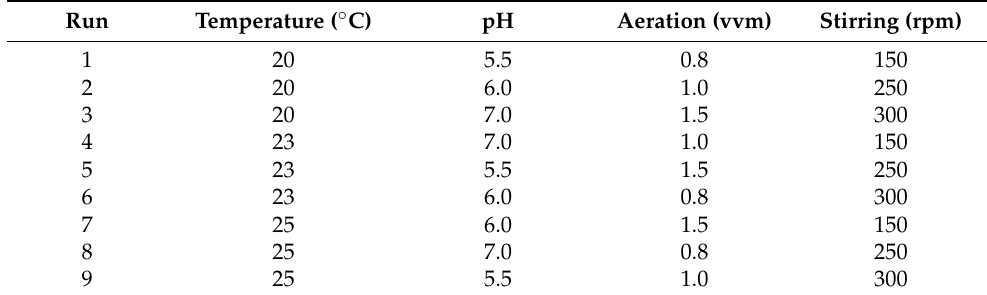
Table 9. The orthogonal array (L 9 ) for uncoded